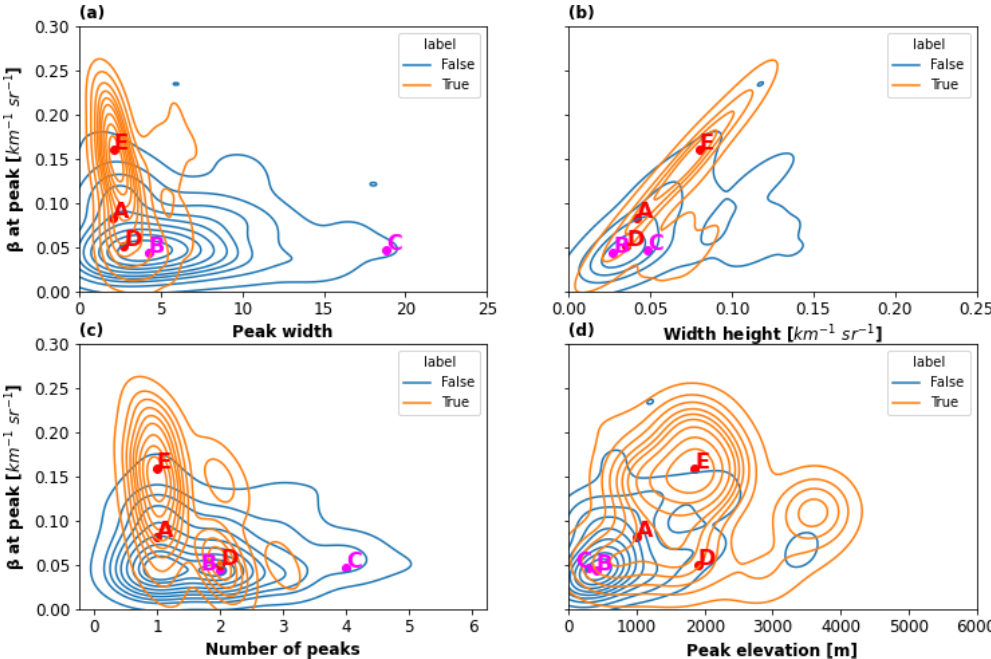
Figure 7. Joint distribution using kernel density estimation plots showing the distribution of peak average properties for 6 January 2019: (a) attenuated backscatter versus peak width; (b) attenuated backscatter versus peak width height; (c) attenuated backscatter versus the number of peaks within the profile; (d) attenuated backscatter versus peak altitude above ground level. Isolines are shown with a spacing of 0.1 and the label “True” corresponds to SLW or mixed phase observed by the reference radar–lidar mask, while “False” indicates no detection by the reference mask. Selected vertical profiles from Figs. 5 and 6 are also shown with red dots (A, D, and E: SLW occurrences, e.g. “True”) and fuchsia dots (B and C: non-SLW occurrences, e.g.